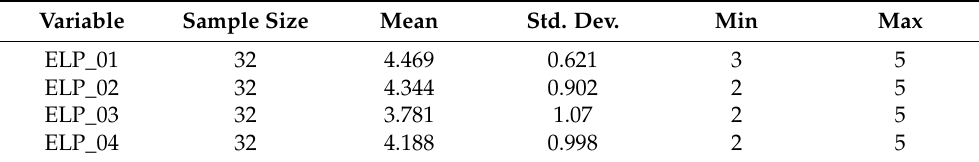
Table 13. Descriptive statistics by e-learning process items.